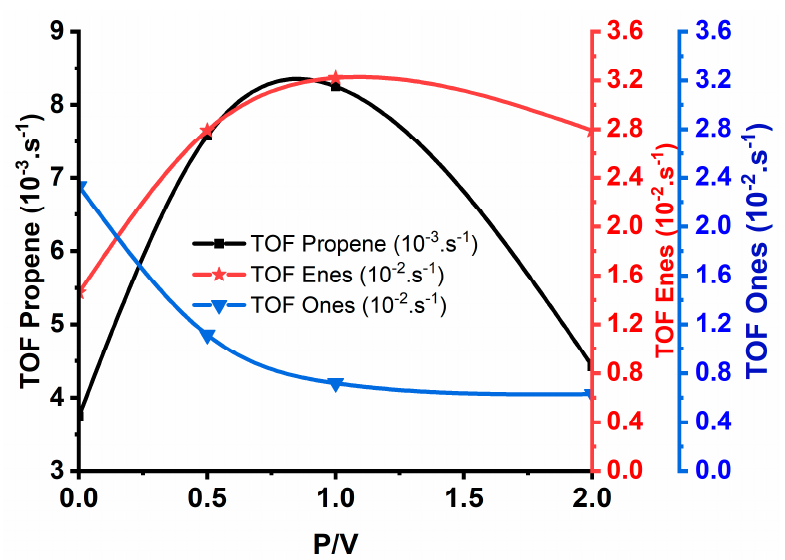
Figure 17. TOF variation as a function of the P/V ratio for the production of propene at 550 °C and for butenes and butanones yields in 2-butanol decomposition at 205 °C in the presence of oxygen. The V-O-V/V-O-Zr and V = O sites play a critical role in the ODH reaction of propane